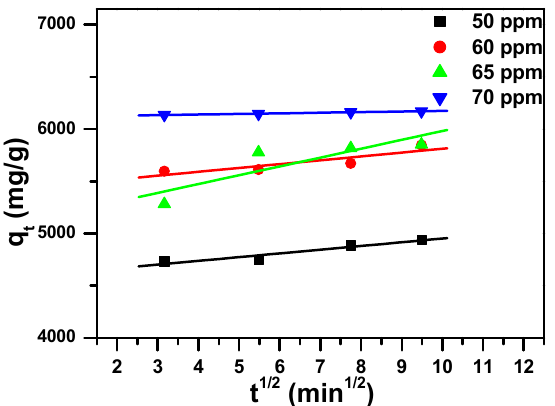
Figure 6. Intraparticle diffusion model plot showing the effect of contact time and initial dye concentration of MB removal by Fe 2 (MoO 4 ) 3 .